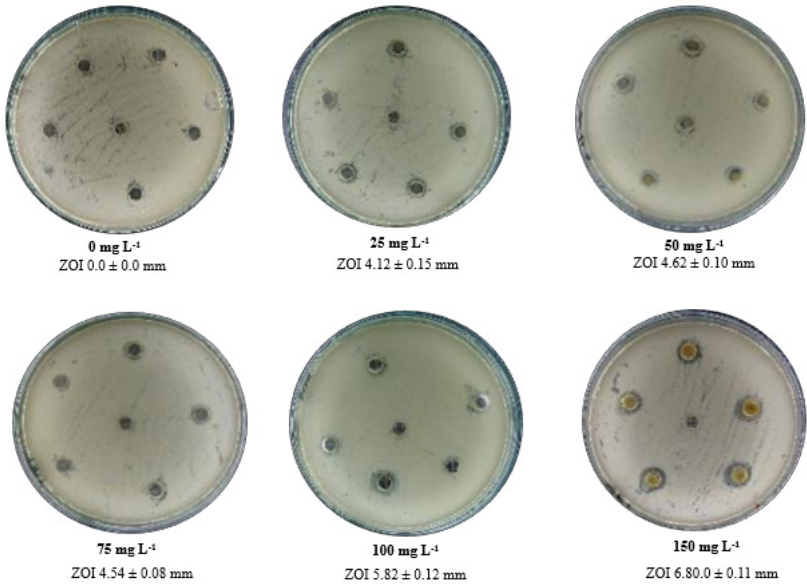
Figure 3. Different concentrations of rosin maleic anhydride nanoparticles tested for the antibacterial susceptibility of MRSE at 5 ×10 5 cfu mL − 1 and 35 °C for 24 h.